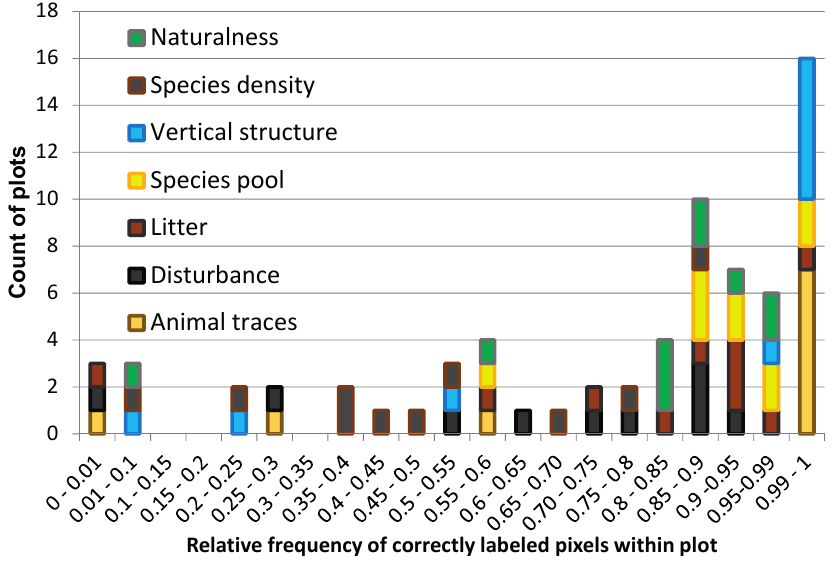
Figure 4. Accuracy assessment of individual CS parameters. Column heights refer to the number of plots having the respective relative frequency of correctly labeled pixels for each CS parameter. Variables where no difference was observed in the field plots are